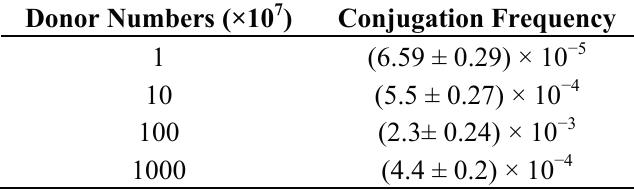
Table 2. Effect of donor-to-recipient on conjugation efficiency with E. coli